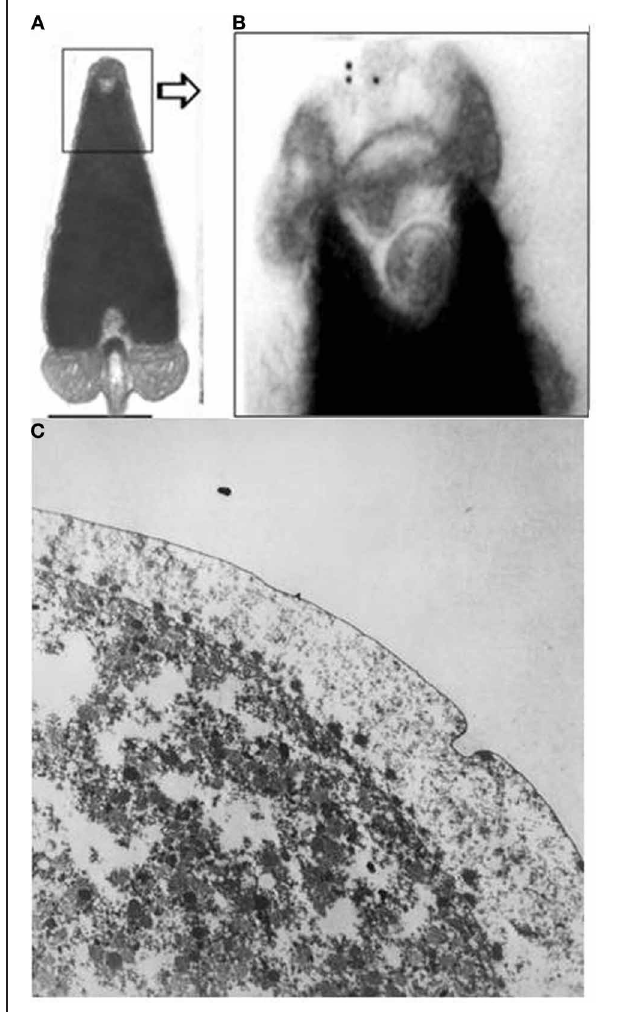
FIGURE 4 | (A,B) ChAT activity in the sperm acrosome (immunogold), electron microscopy images (Angelini et al., 2004; original images (A) bar = 0.5 μ m; (B) × 20,000): (C) The arrows show some of the AChE-positive cortical granules exocytosized into the perivitelline space at fertilization ( × 20,000). OsO 4 was not used for fixation, in order to maintain the activity of AChE.